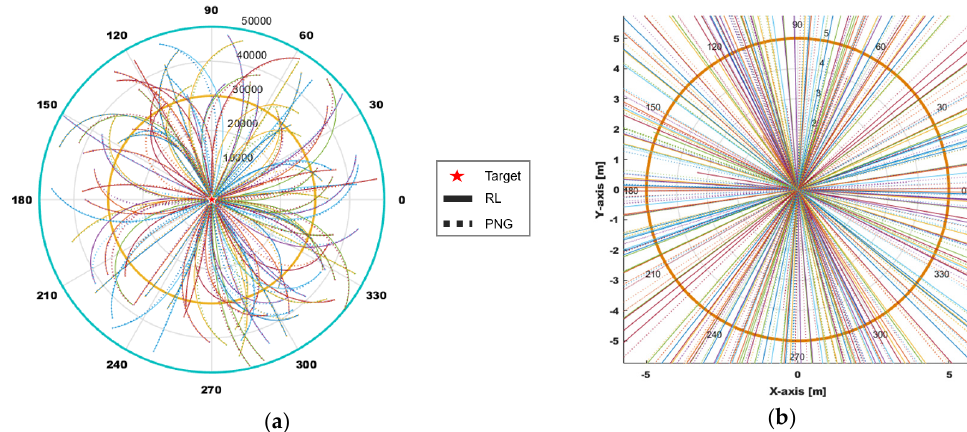
Figure 12. ( a ) Simulation trajectories; ( b ) Trajectories near target.